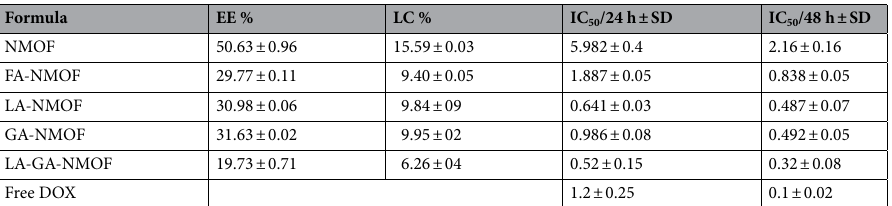
Table 1. Indicating both of entrapment efficiency, loading capacity of DOX. HCL to NMOF and FA-NMOF, LA-NMOF, GA-NMOF L-G-NMOF, and cytotoxicity activity of DOX loaded formulations at two-time intervals, (24, 48